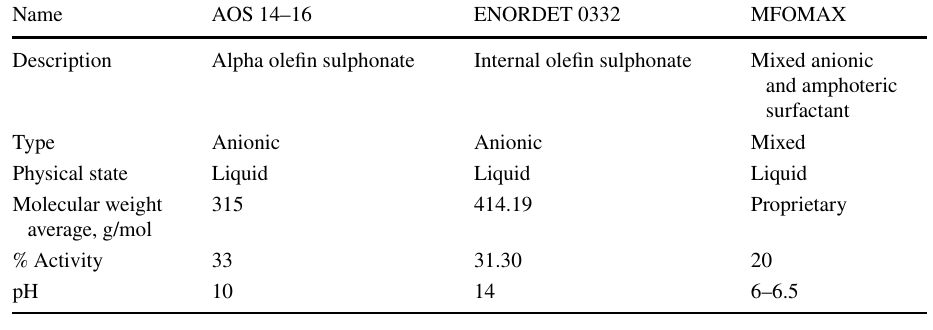
Fig. 1 General structure of Alpha Olefin Sulfonate (AOS) (left) and Internal Olefin Sulfonate (ENORDET) (right) surfactants (Barnes 2010; Wib- bertmann et al.